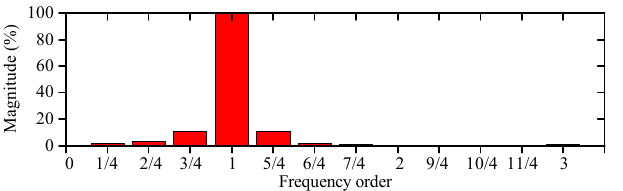
Figure 2. Typical frequency spectrum of phase back-EMF when partial demagnetization happens.